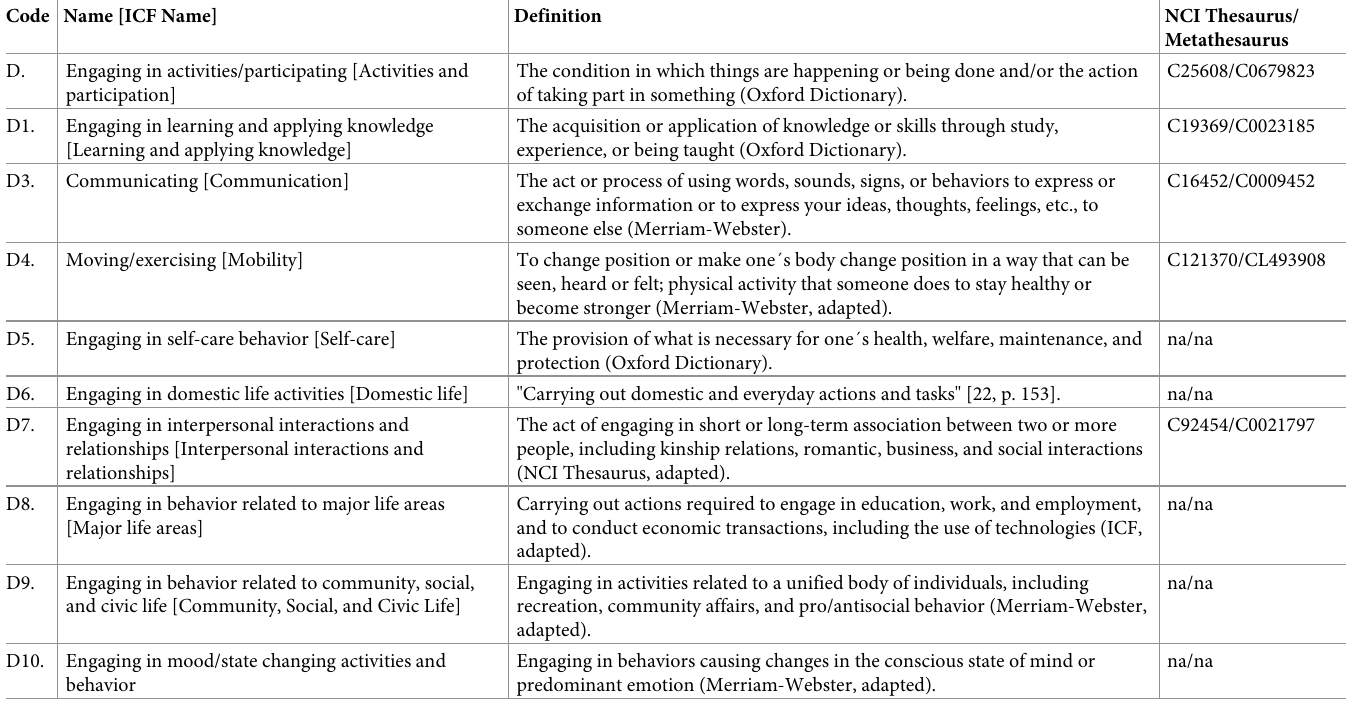
Table 3. IC-Behavior top level nodes, definitions, and links to NCI